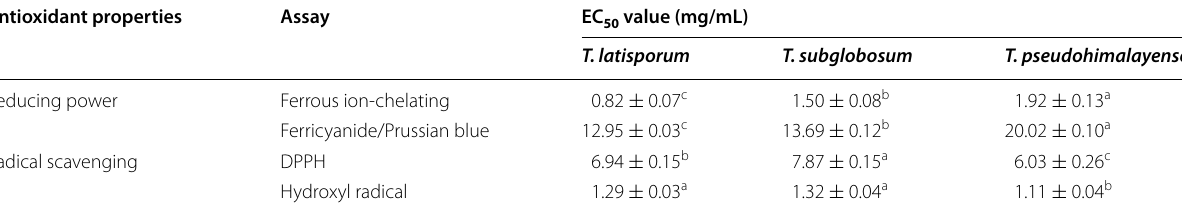
The results are presented in EC 50 values, meaning that higher values correspond to lower reducing power, radical scavenging activity. EC 50 is the concentration of the extract that corresponds to 50% of antioxidant activity for the ferrous ion-chelating, DPPH, hydroxy, and or 0.5 of absorbance for the ferricyanide/Prussian blue assays a,b,c In each row, the different letters represent significant differences between samples (p < 0.05)